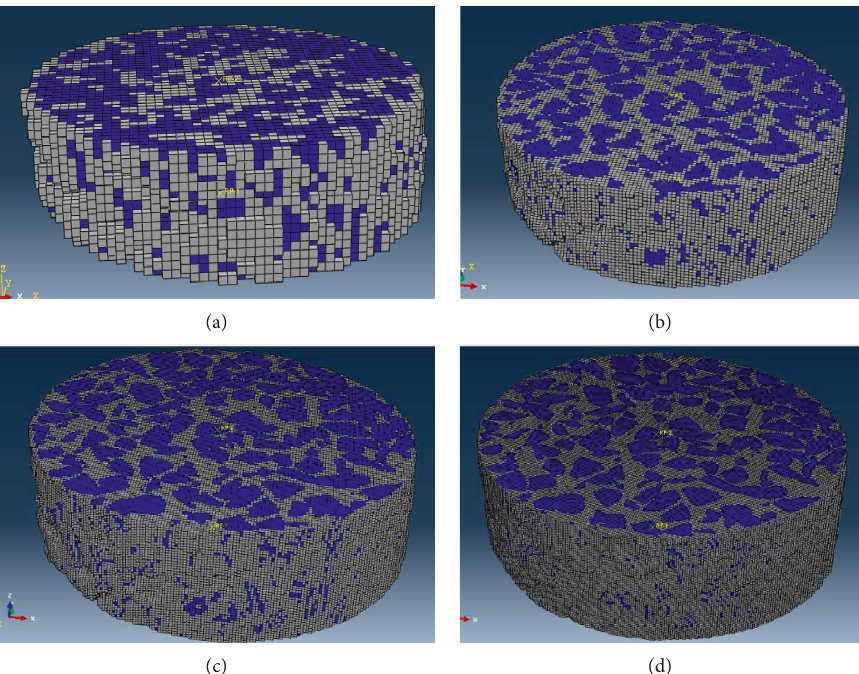
Figure 6: Flow chart of numerical modeling for asphalt mixture.